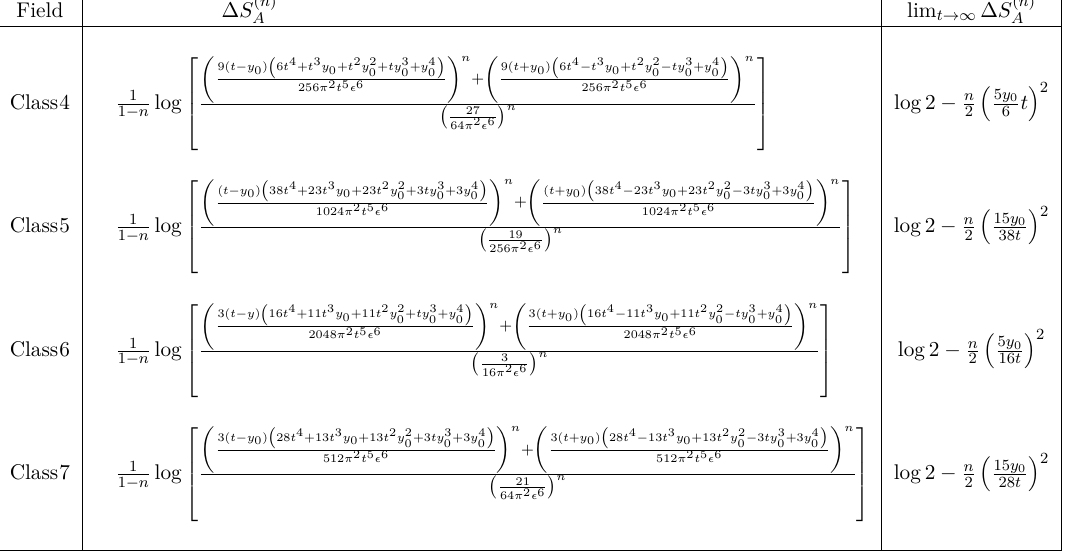
Table 5 . Rényi entropy growth for of symmetric tensors under both SO(2) T × SO(2) L , Class 4, 5, 6, 7 together represent the 9 components of the symmetric tensors. The polynomial in r determining the Rényi entropy growth is a 5th order polynomial and the power of the (1 + r ) is unity.